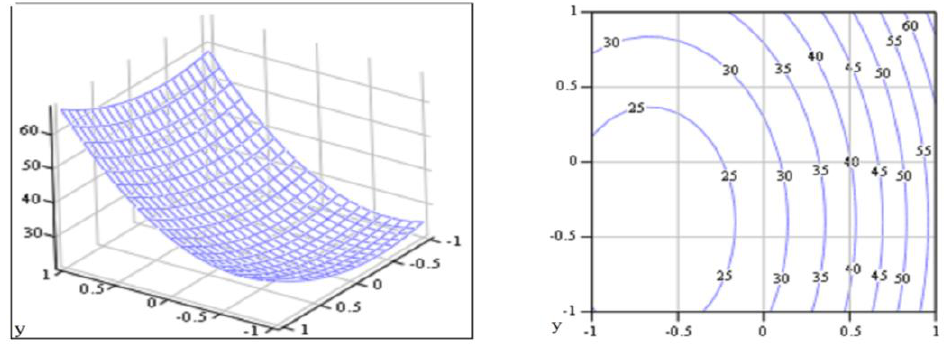
Figure 7. Graph and contour curves of the dependence factors of criterion Y on factors х 2 , х 3 for apricot, when х 1 = 0.